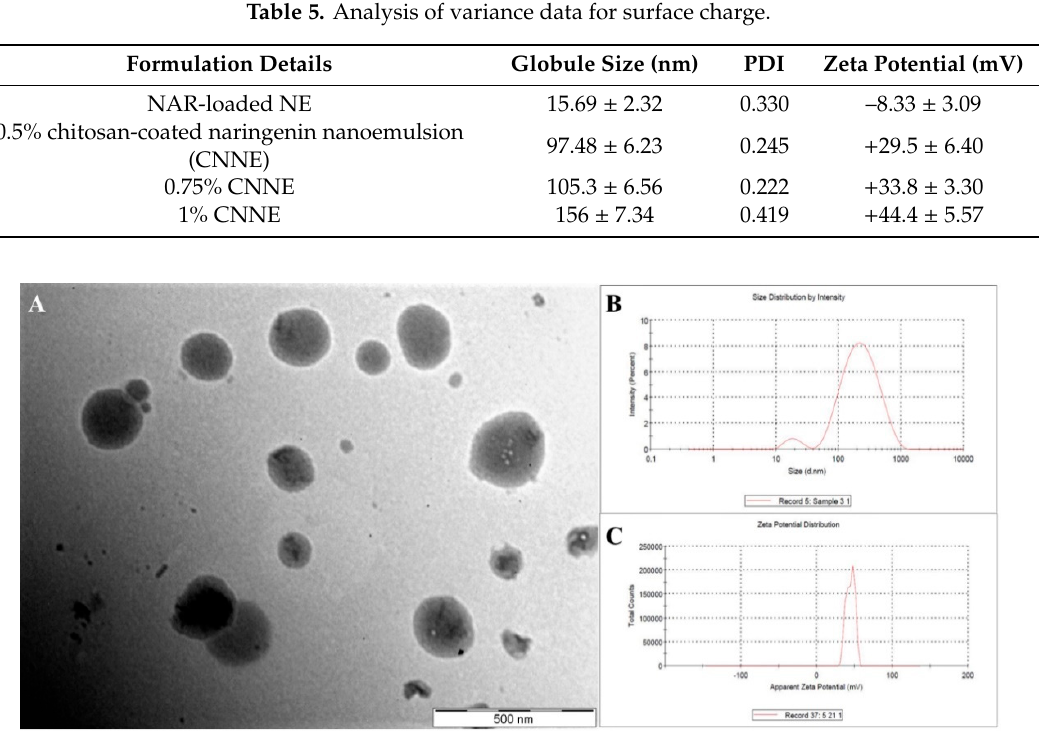
Figure 7. Representation of morphology of the optimized (1%) chitosan-coated naringenin nanoemulsion ( A ), particle size distribution ( B ) and zeta potential ( C ).